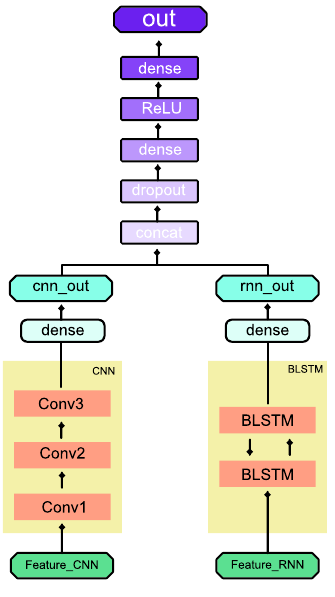
Figure 4. BiLSTM-CNN